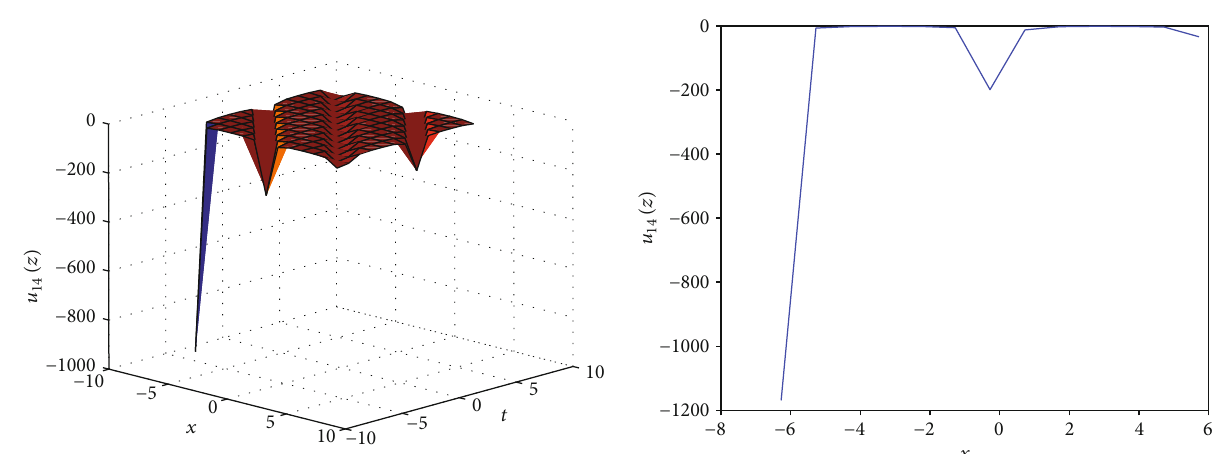
ð z Þ by choosing the values γ = 4 , ϑ = 5 , λ = 1 , ω = 1 , c = 1 , and t = 0 for the 2D graphic. Figure 4: The 3D and 2D graphics of u 14